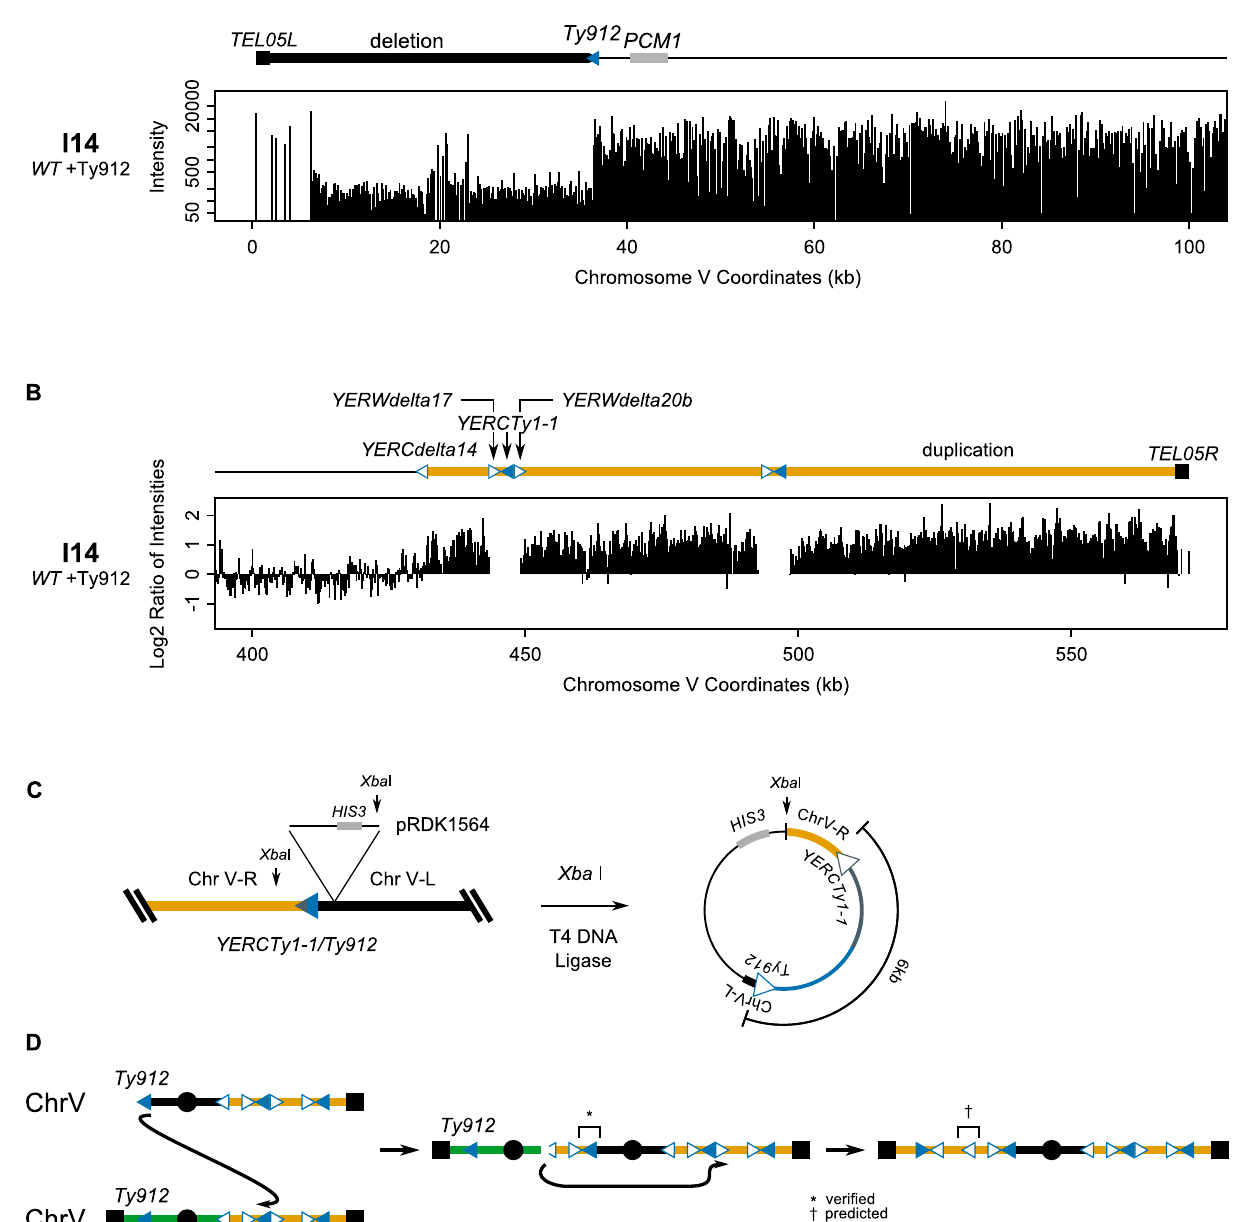
Figure 4. The dicentric structure of isolate I14 is resolved by Ty-mediated recombination. A. Deletion of the region between TEL05L and Ty912 in isolate I14. B. Duplication of the region between YERCdelta14 and TEL05R . C. Schematic of the integration of pRDK1564 near the fusion junction and subsequent steps utilized to create a vector cloning the fusion junction. The Ty fusion junction measures approximately 6 kb, the size of one full length Ty1 element. D. Exposed Ty912 DNA invades YERCTy1-1 , copying through the centromere and creating a dicentric chromosome. The unstable dicentric chromosome breaks at YERCdelta14 and invades YERWdelta20b , copying the rest of the duplicated region to TEL05R . * is a verified junction; { a predicted